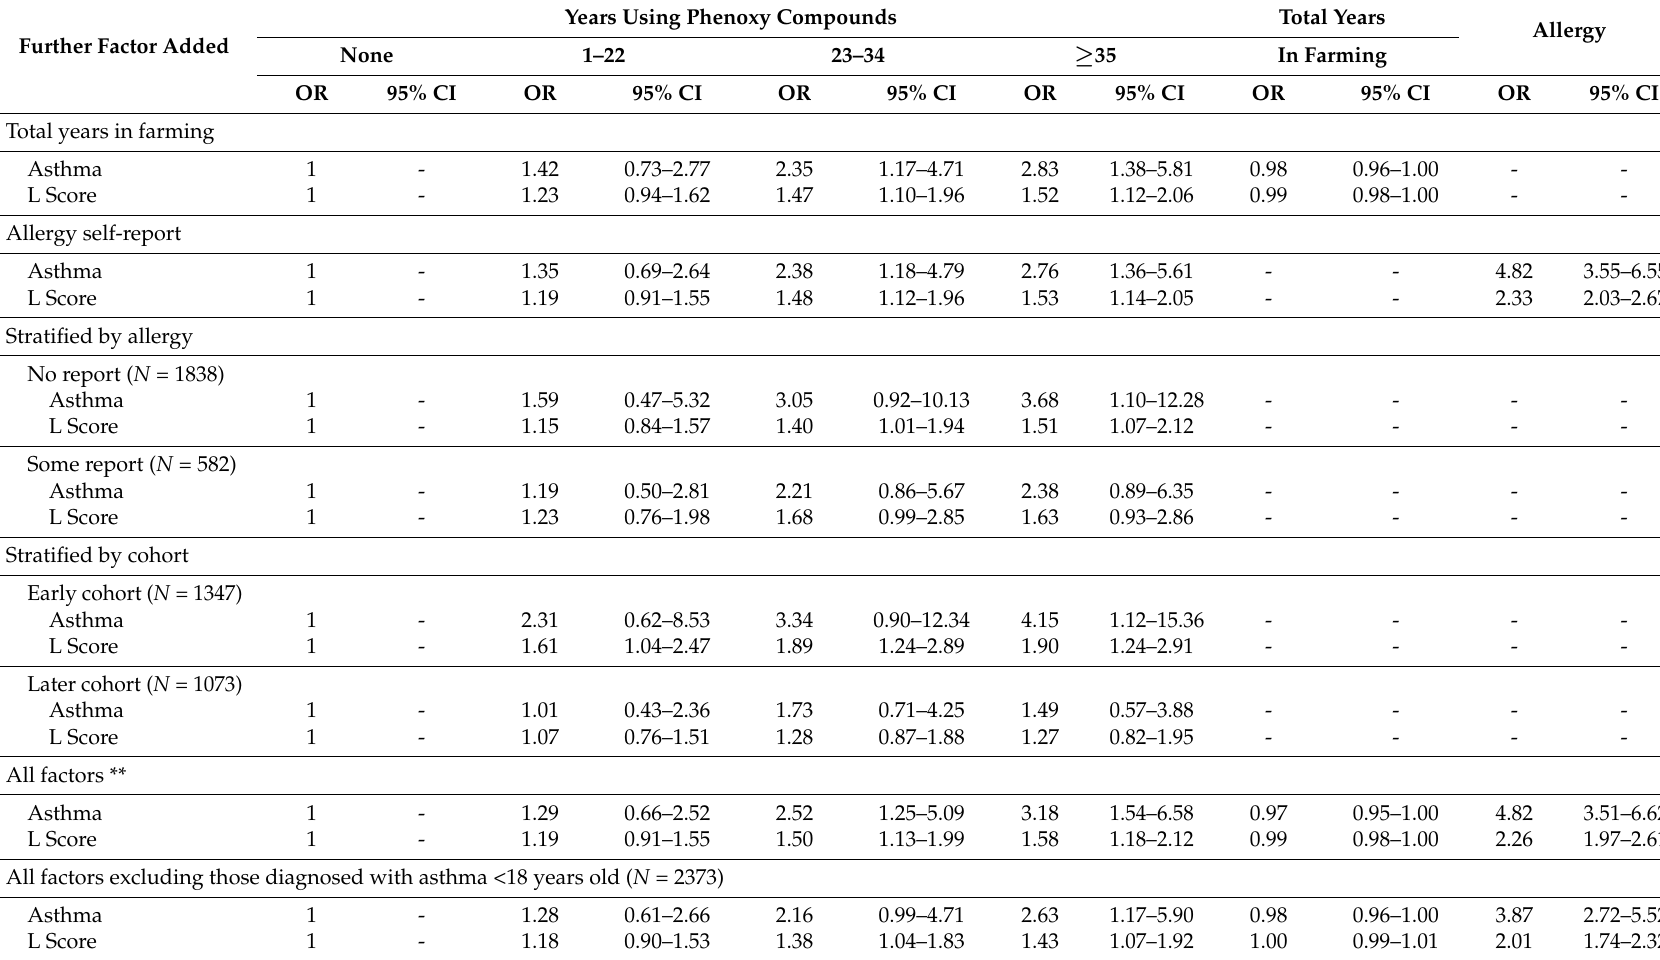
Table 6. Effect on risk estimates * for phenoxy compounds with self-reported asthma and Lscore of adding further factors and of stratification ( N = 2420).